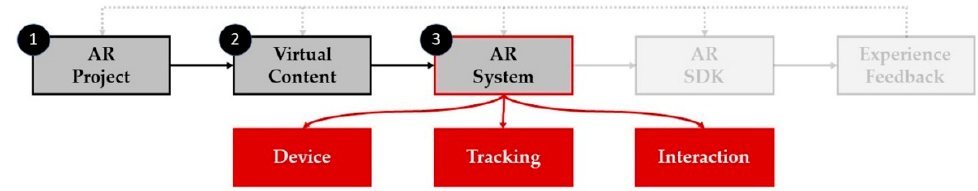
Figure 10. Block diagram of the main features of the virtual content creation.